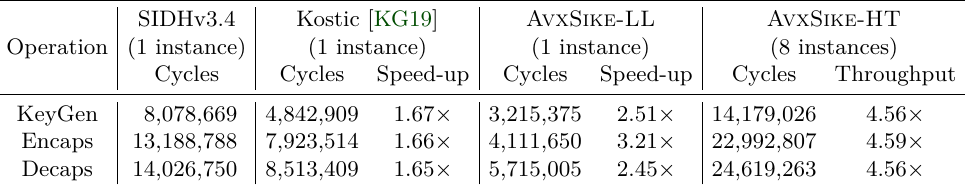
Table 5: Execution times (in cycles) of implementations of SIKEp503 on an Intel Core i3-1005G1 processor. The cycle-counts for SIDHv3.4, Kostic-Gueron’s work [KG19], and AvxSike-LL are for the execution of one instance of an operation and “Speed-up” is the speed-up factor compared to SIDHv3.4. The cycle-counts for AvxSike-HT are for the execution of eight instances of an operation and “Throughput” is the throughput gain compared to SIDHv3.4 when it executes eight